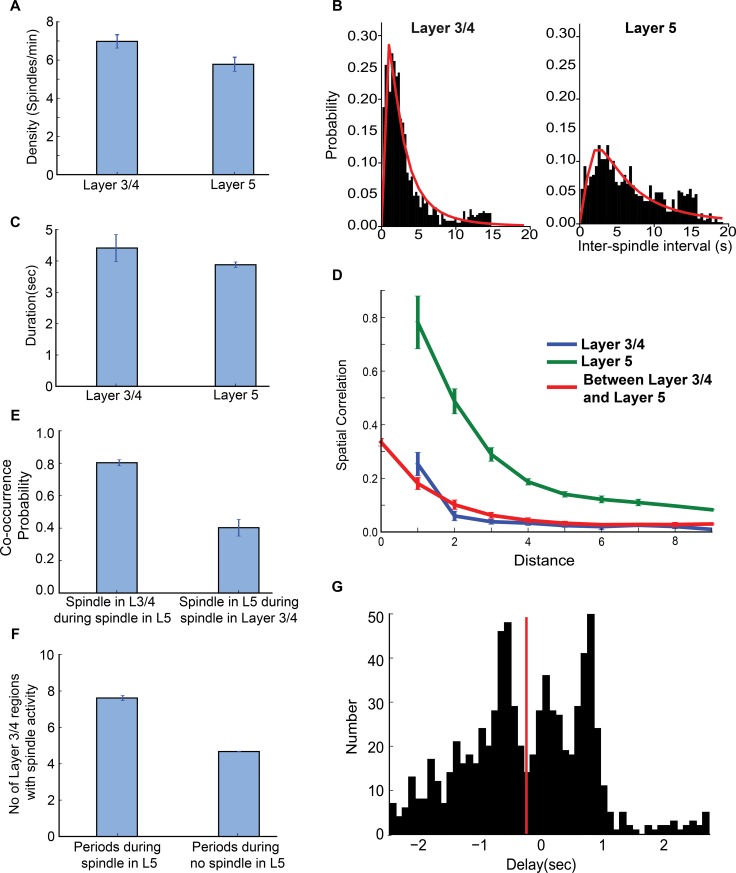
Statistical proprieties of sleep spindles in the core and matrix systems.(A) Spindle density measured from the filtered averaged network activity in the core and matrix systems, with error bars indicating standard error across different network locations. (B) Histograms of inter-spindle intervals reveal a non-normal distribution in the occurrence of spindles in both the core and matrix systems. (C) Spindle duration as measured by the onset to offset of spindle that was identified by a threshold measure (see method section for details). (D) Spatial correlation within and between layers measured as a function of the distance between network sites. (E) Probability of co-occurrence of spindle in core and matrix system. (F) Probability of spindle co-occurrences in the core and matrix systems. (G) Delay between the onset of spindles in the core and matrix, negative values indicate that the spindle in the core precedes that in the matrix.